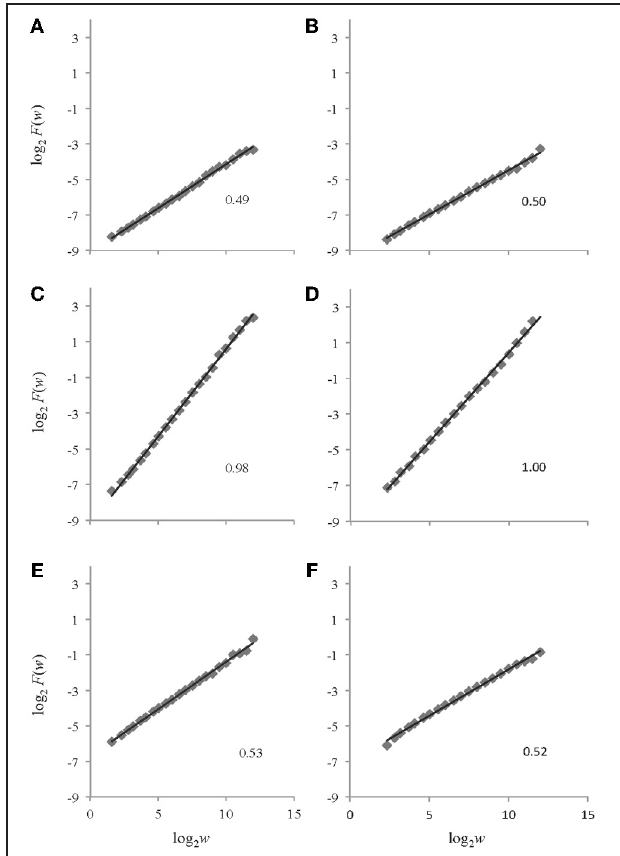
FIGURE 5 | Example log 2 F ( w ) vs. log 2 w plots returned by AFA for the time series depicted in Figure 4. The plots on the left side (panels A, C, and E ) are from AFA using a polynomial order of M = 1 while those on the right side (panels B, D, and F ) are from AFA using a polynomial order of M = 2. Plots A and B are for white noise, plots C and D are for pink noise, and plots E and F are for brown noise. The respective H fGn ( A, B, C, and D ) and H fBm ( E and F ) values are shown for each signal.